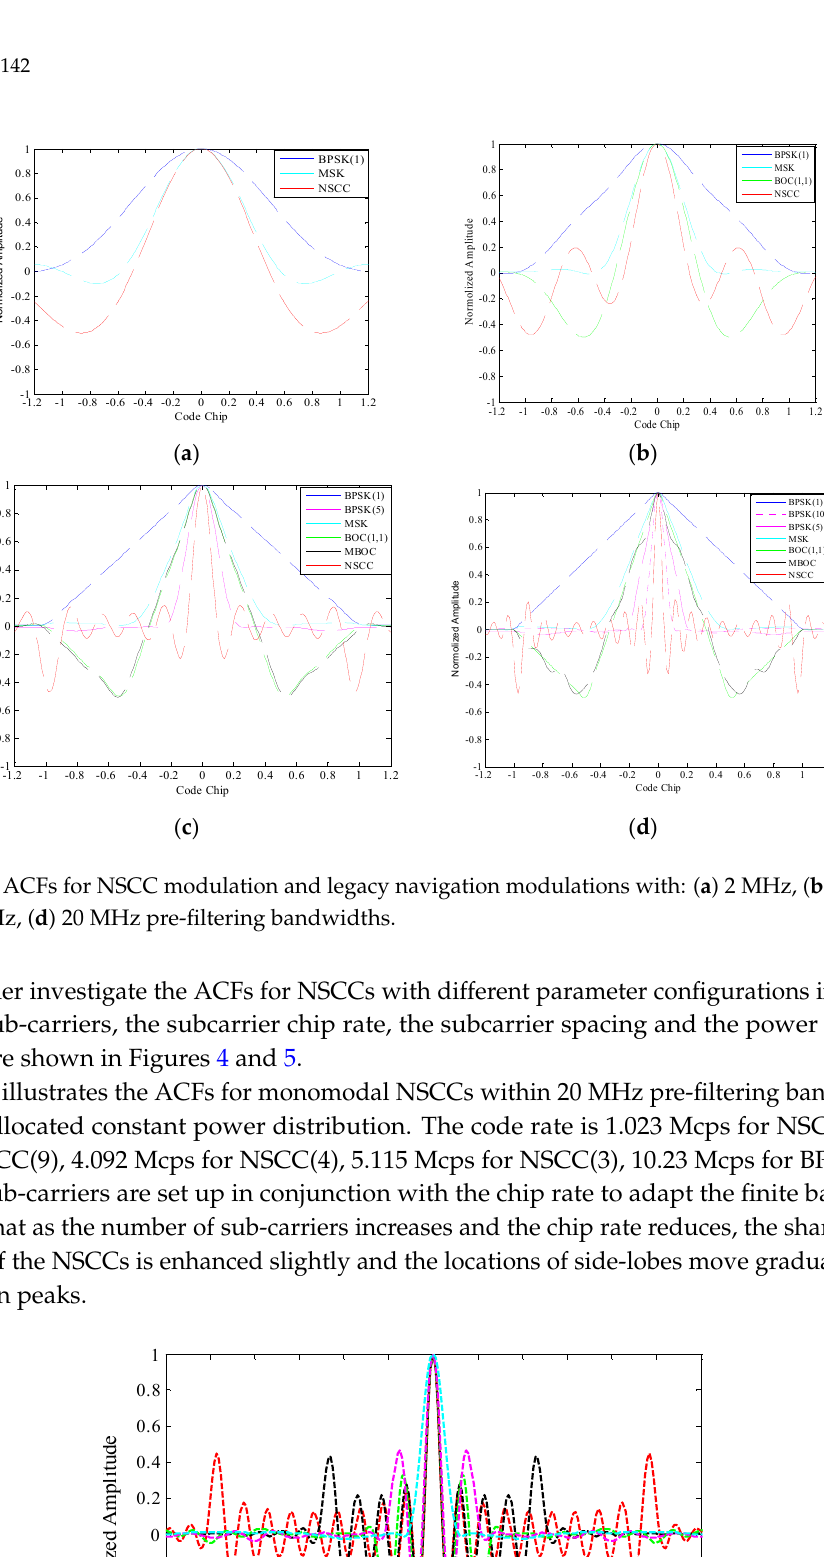
Figure 5. Comparison of ACFs for NSCC baseline structures within 20 MHz.